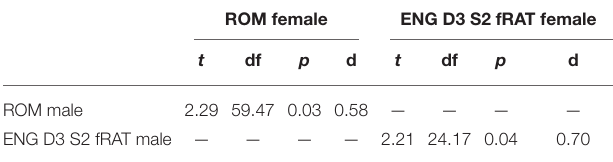
TABLE A5 | Welch test results for accuracy without a time frame between